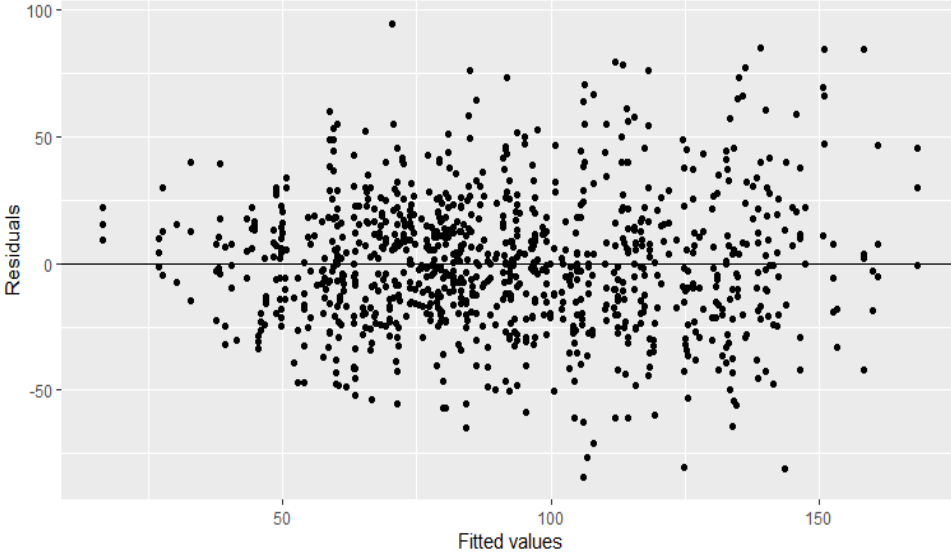
Figure A5. Time series of the chains and density curves of the effect of genotypes 143, 153, 18, and 700.